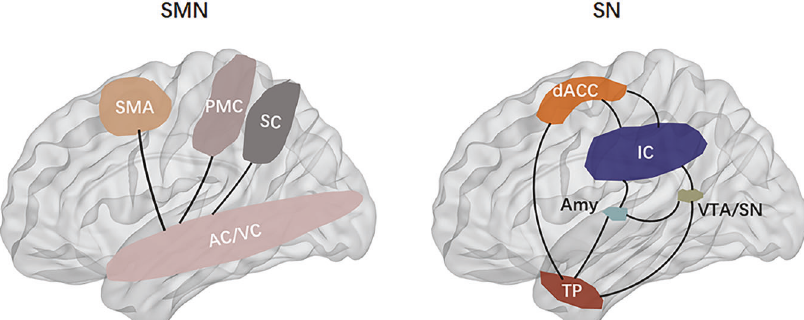
Fig. 4 The sensorimotor network (SMN) mainly comprises the motor cortex (precentral gyrus, premotor, and supplementary motor cortex) and middle cingulate cortex, somatosensory cortex (postcentral gyrus and parietal cortex), auditory cortex (superior temporal gyrus), as well as visual cortex (occipital cortex and associated dorsal parietal and inferior temporal areas). The salience network (SN) consisting of the insular cortex, the dorsal ACC, the amygdala, and the temporal pole, is involved in interceptive awareness, task-set maintenance, and detection of salient stimuli from the environment. dACC dorsal ACC, IC insular cortex, Amy amygdala, TP temporal, VTA/SN ventral tegmental area/ substantia nigra. SMA supplementary motor area, PMC primary motor cortex, SC somatosensory cortex, IC insular cortex, AC auditory cortex, VC visual